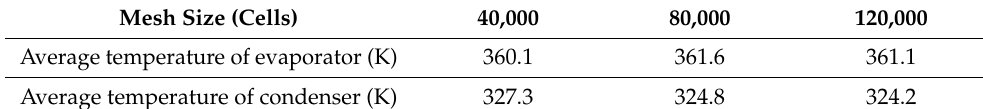
Table 2. The results of the grid independency for validation part.